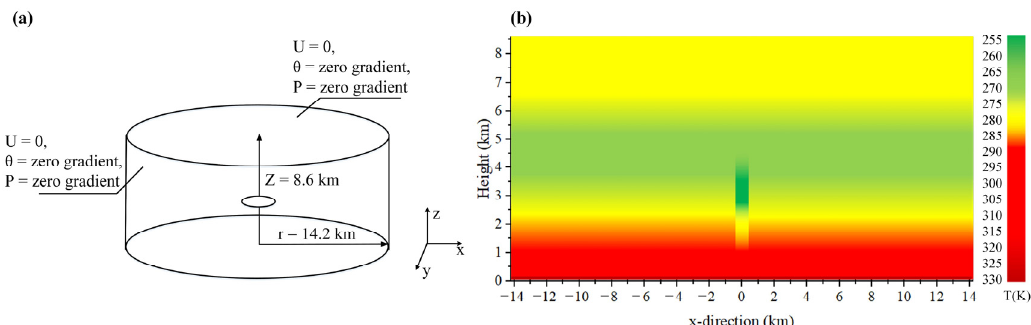
Figure 2. Initial and boundary conditions in a three-dimensional cylindrical model. ( a ) A simulated cold pool with vertical vortex was initially located at the model centre; ( b ) The initial temperature field of the cylindrical computational model in its radial direction.